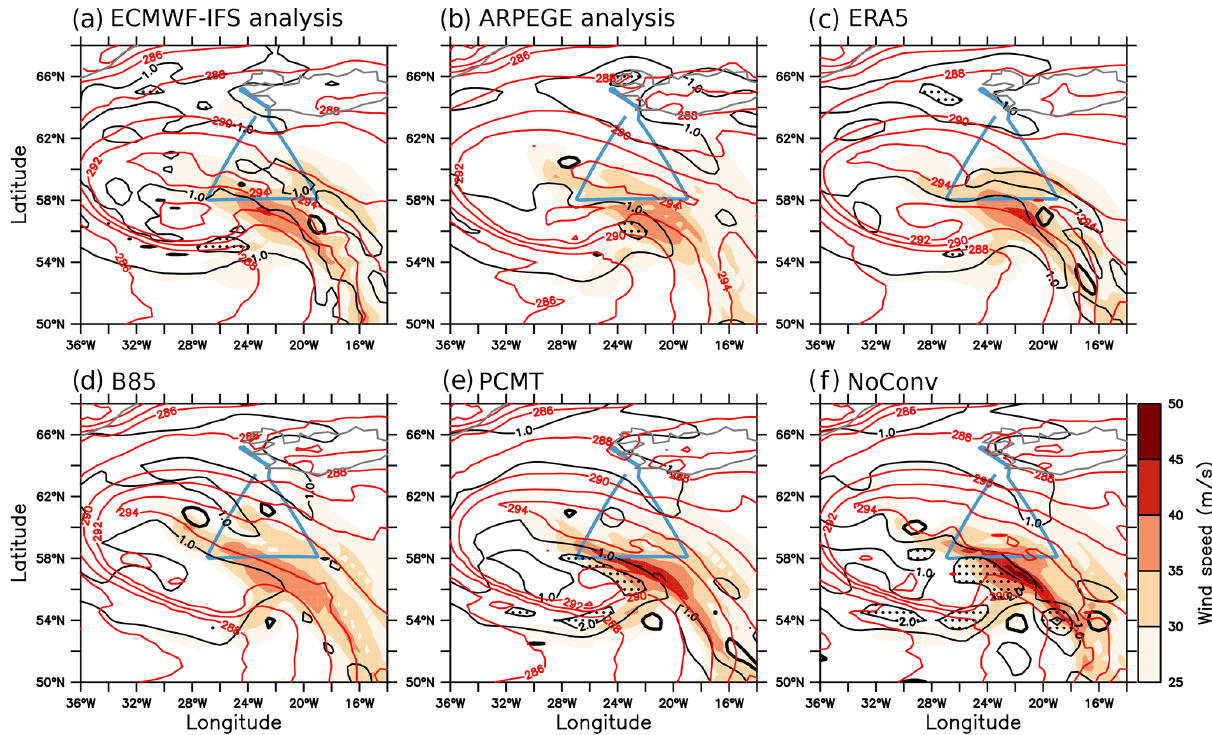
Figure 3. Wind (shadings) and potential vorticity (black contours with hatched areas for values superior to 2 PVU and bold contours for 0 PVU) at 600hPa with potential temperature averaged between 750 and 850hPa (red contours) at 15:00UTC, 2 October 2016 for (a) ECMWF-IFS analysis, (b) ARPEGE analysis, (c) ERA reanalysis, (d) simulation with B85, (e) simulation with PCMT and (f) simulation with explicit deep convection. The Flight F7 of the SAFIRE Falcon is shown as a blue